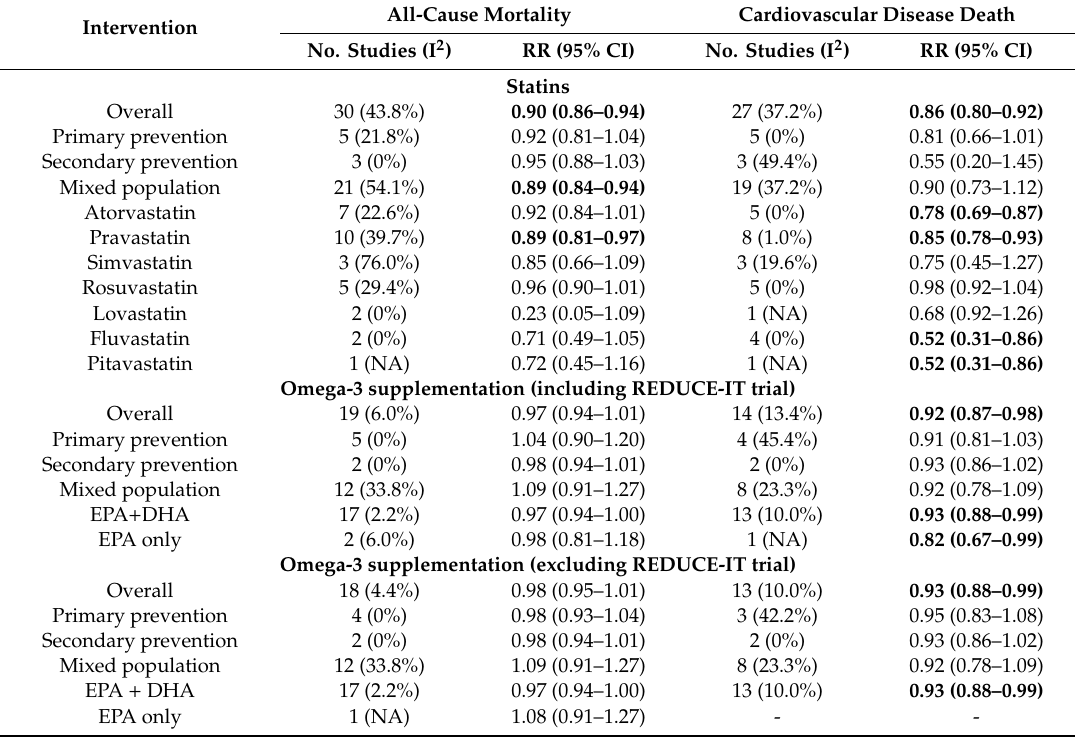
Table 1. Meta-analysis of the associations between statins and omega-3 supplementation with all-cause mortality and cardiovascular